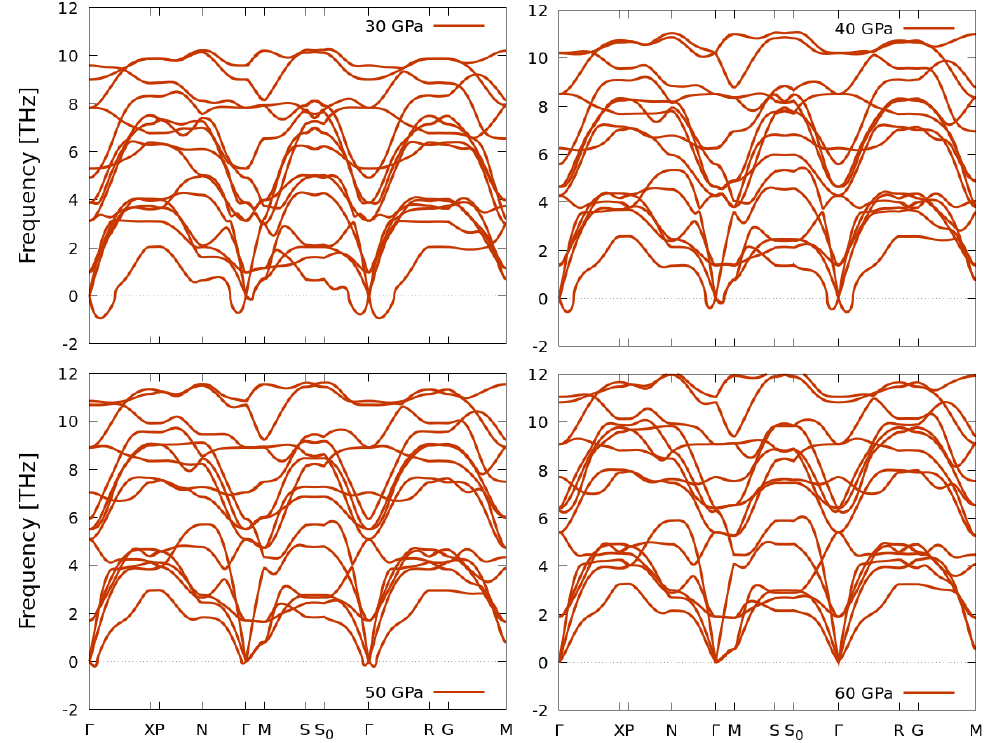
Figure 6. Harmonic phonon dispersion curves of the I4/mmm phase of the Sb 2 S 3 compound between 30 and 60